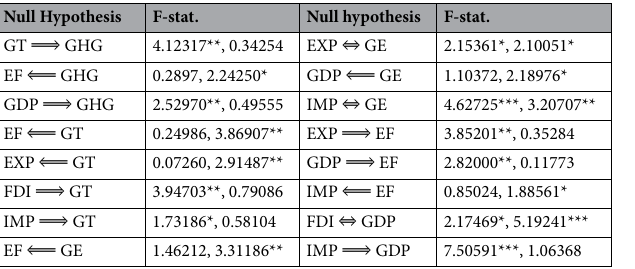
Table 7. Panel Causality Check. Note: The superscripts ***, ** & * signify statistical significant at the 1%, 5% and 10% respectively.